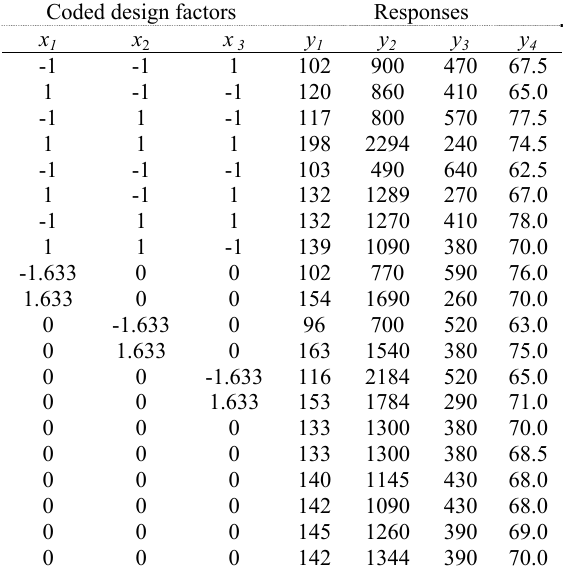
Table 2. Design matrix and experimental results Coded design